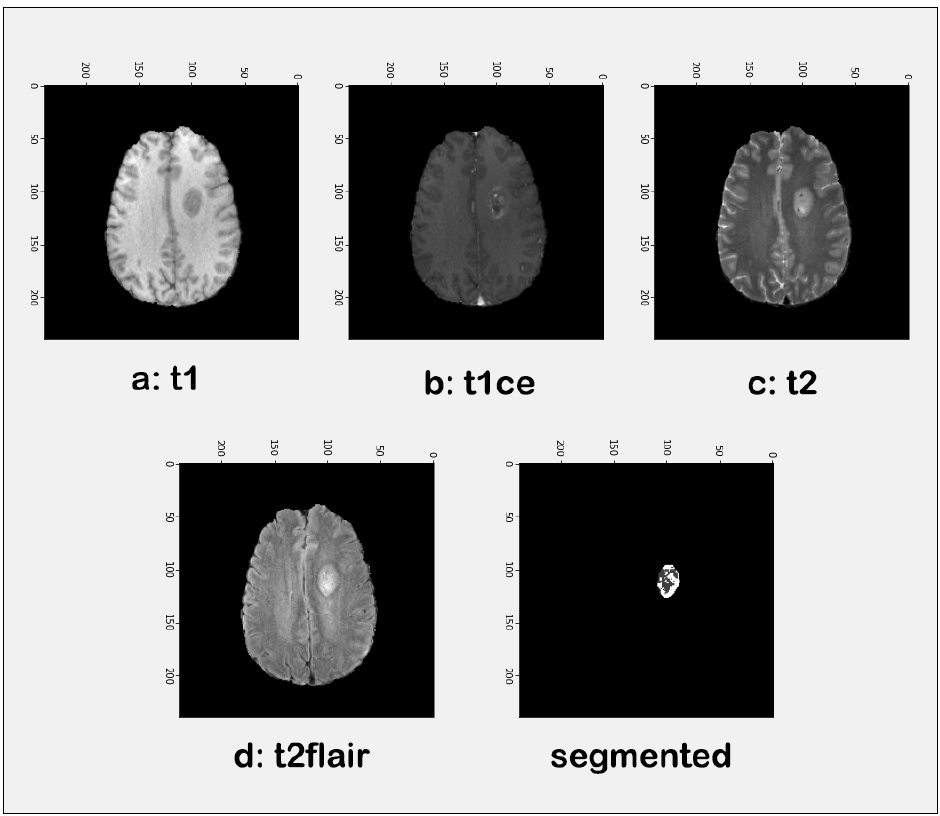
Figure 3. Different modalities of the images in the Brats-2020 dataset. Table 1. Demographic information of the patients in